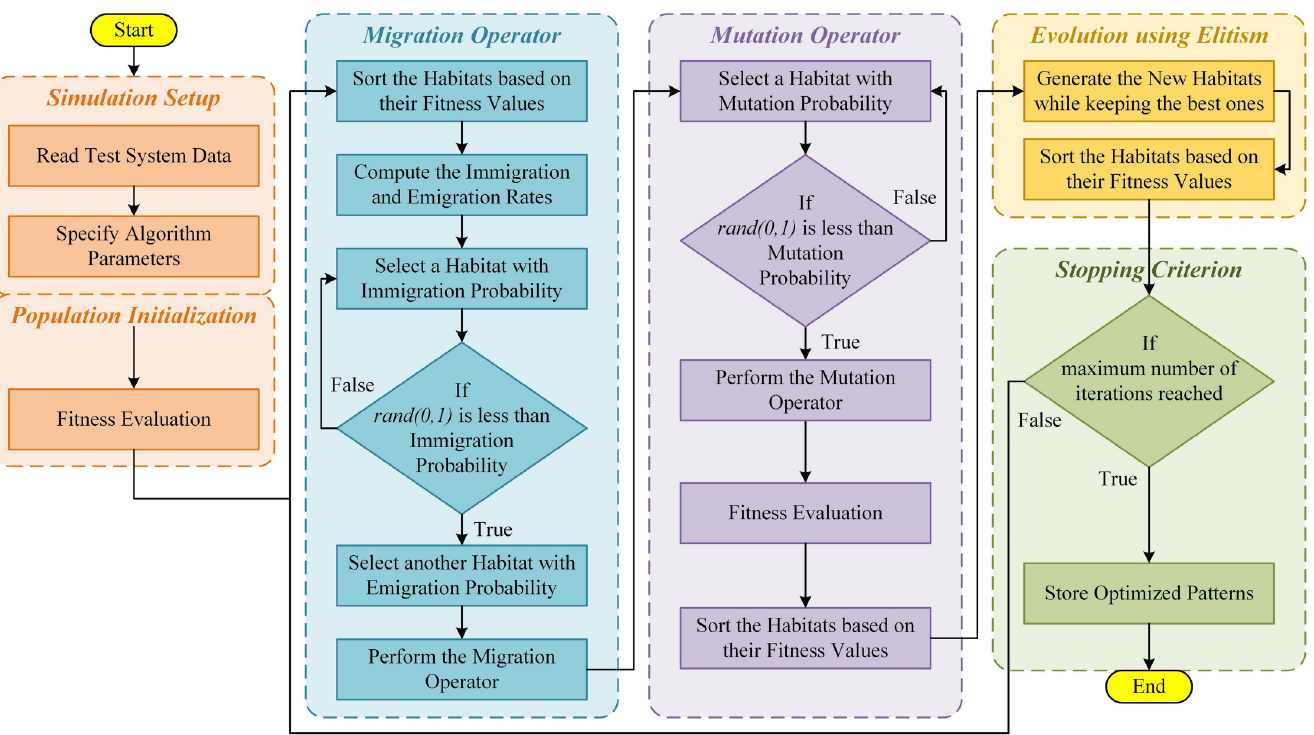
Fig 3. Flow chart of